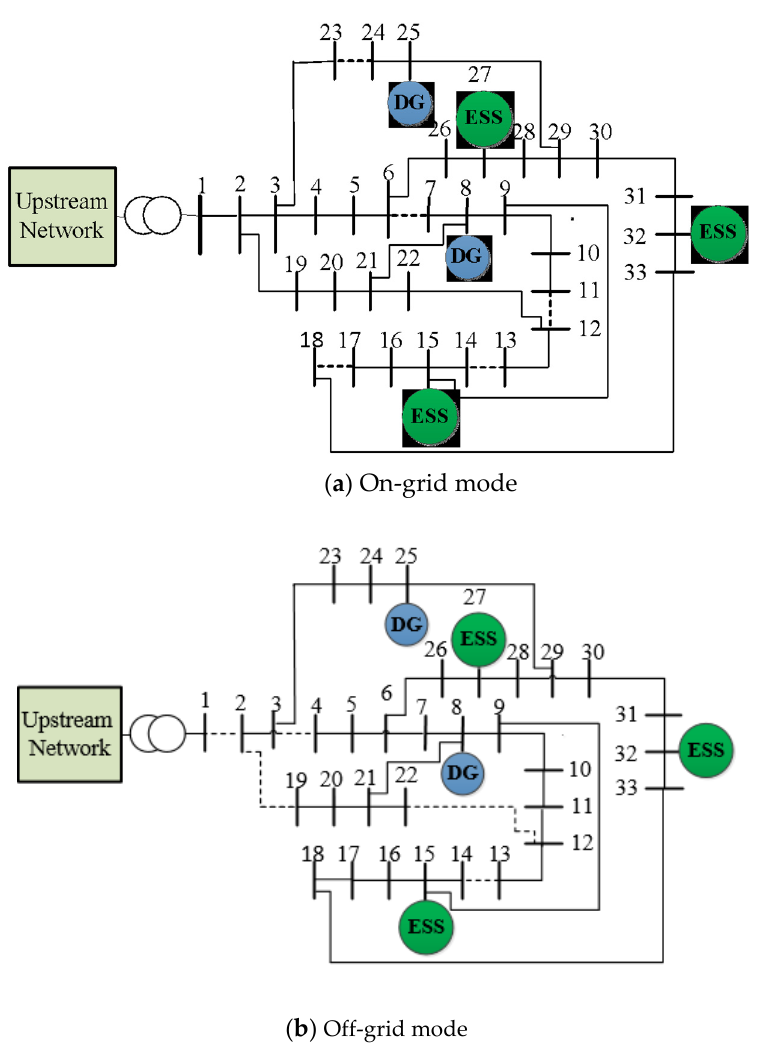
Figure 5. Optimal configuration of the network in BC: ( a ) on-grid operation mode; ( b ) off-grid operation mode.